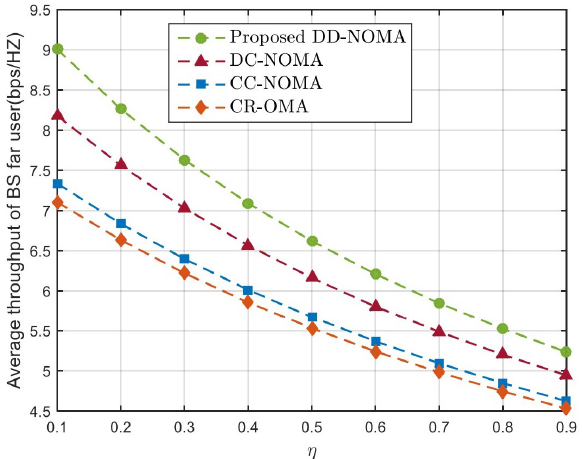
Figure 8. Average throughput of BS far users under different η .